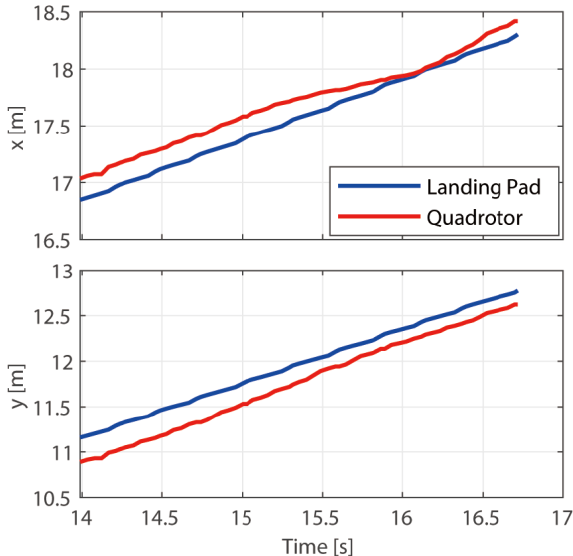
In case 2, the UGV performs circular motion with a linear velocity of 0.8 m/s and an angular velocity of 0.15 rad/s between buildings. As shown in Figure 10, the quadrotor is able to land on the UGV as the Gaussian noise increases. It can be seen that the drone can follow the UGV while avoiding obstacles. As shown in Figure 11, the quadrotor ap- proaches the UGV in the x and y directions after 15 s and lands on it in 28 s. Figure 12 Figure 8. Position of quadrotor and landing pad with σ = 0.01. shows the position error near the landing point. Figure 8. Position of quadrotor and landing pad with σ = 0.01.